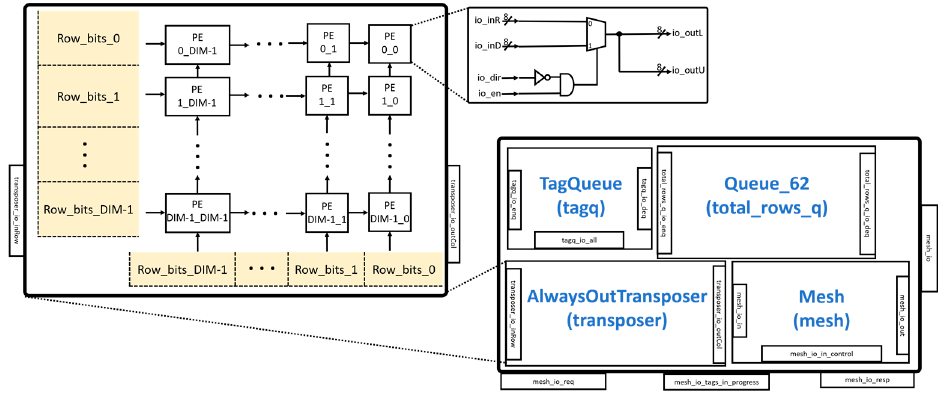
Figure 7. MeshWithDelays module.